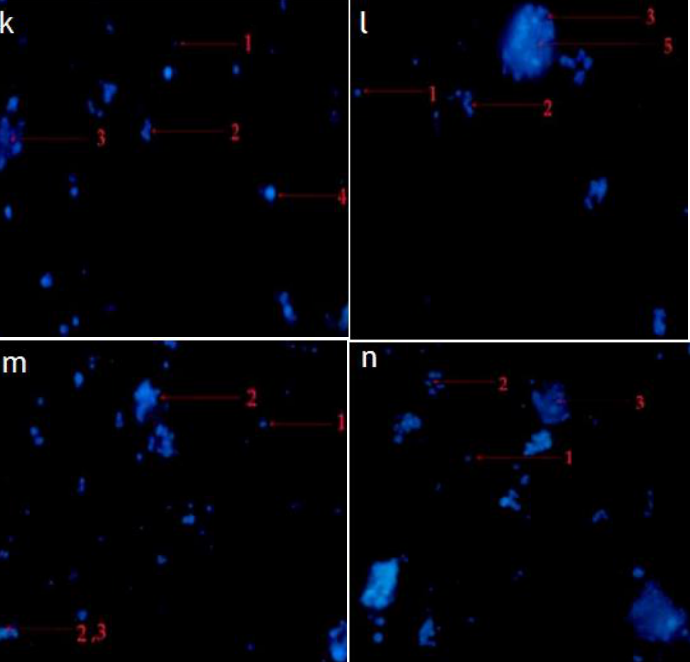
Figure 9. Representative photomicrograph shows morphological changes of MCF-7 cancer cells. MCF-7 cells treated with hexane fraction of C. minima (( k ): 45 μg/mL; ( l ): 90 μg/mL); and chloroform fraction of C. minima ; ( m ): 50 μg/mL; ( n ): 100 μg/mL) for 24 h and imaged by Hoechst 33342 staining method (magnification 200×). MCF-7 cells treated with hexane fraction of C. minima (( k ): 45 µ g/mL; ( l ): 90 µ g/mL); and chloroform fraction of C. minima ; ( m ): 50 µ g/mL; ( n ): 100 µ g/mL for 24 h and imaged by Hoechst 33342 staining 2.5. Hexane and Chloroform Fractions of C. minima Induced Apoptosis and DNA Fragmentation by a Caspase-Dependent Pathway in Human Rhabdomyosarcoma Cells and by a Caspase- method (magnification 200 ×